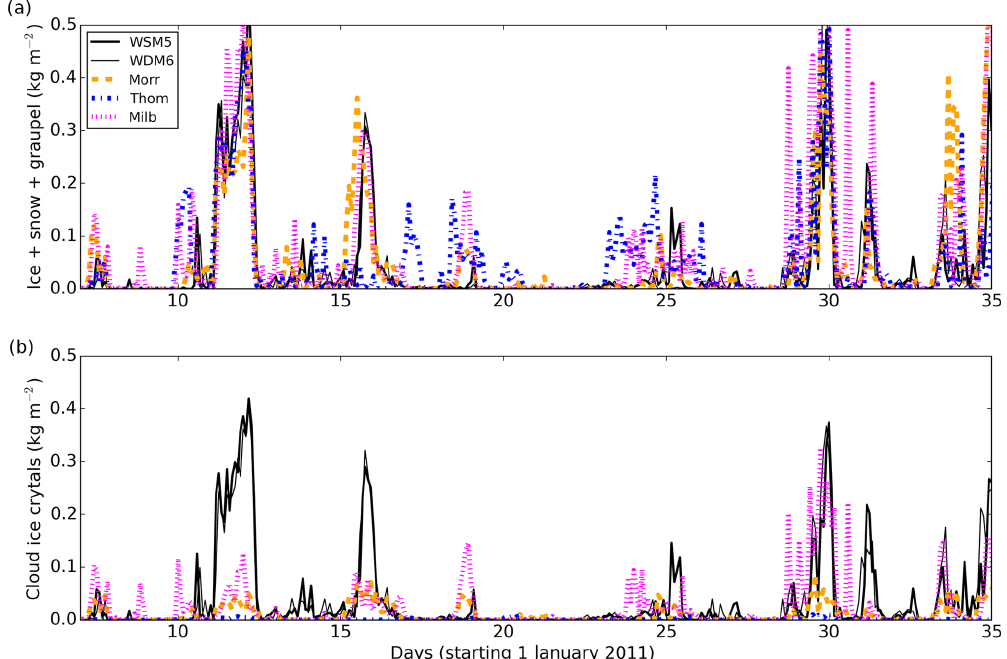
Figure 3. (a) Same as Fig. 2 but for the total ice phase (ice, snow, and graupel particles). (b) Same as Fig. 2 but for cloud ice particles